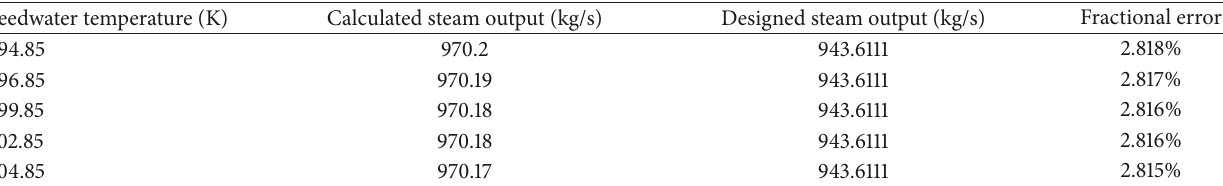
Table 14: The influence of feedwater temperature on the steam output.